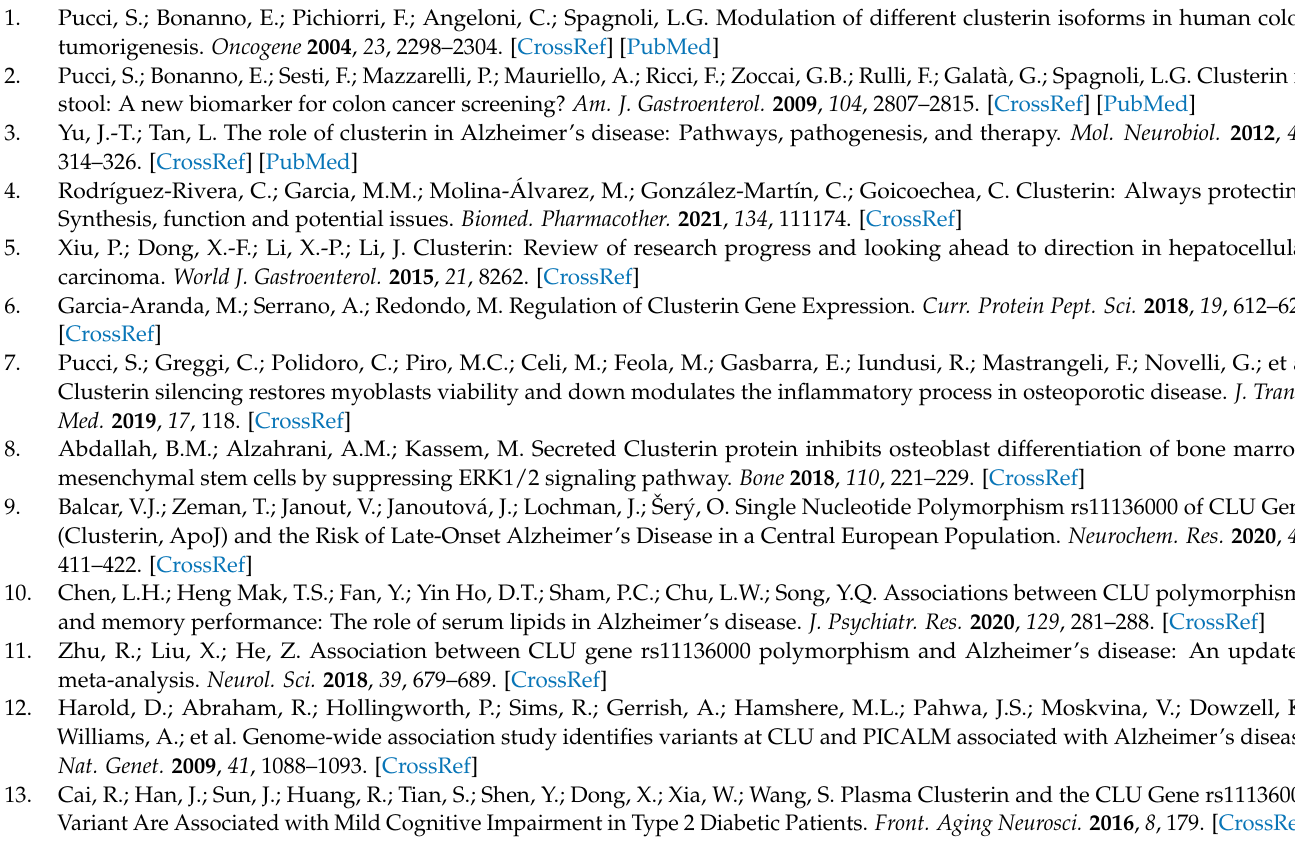
sies and bone morphometric analysis, Figure S2: Characterization of primary osteoblast cultures, Figure S3: Expression level of CLU in OP and CTR individuals with different rs11136000